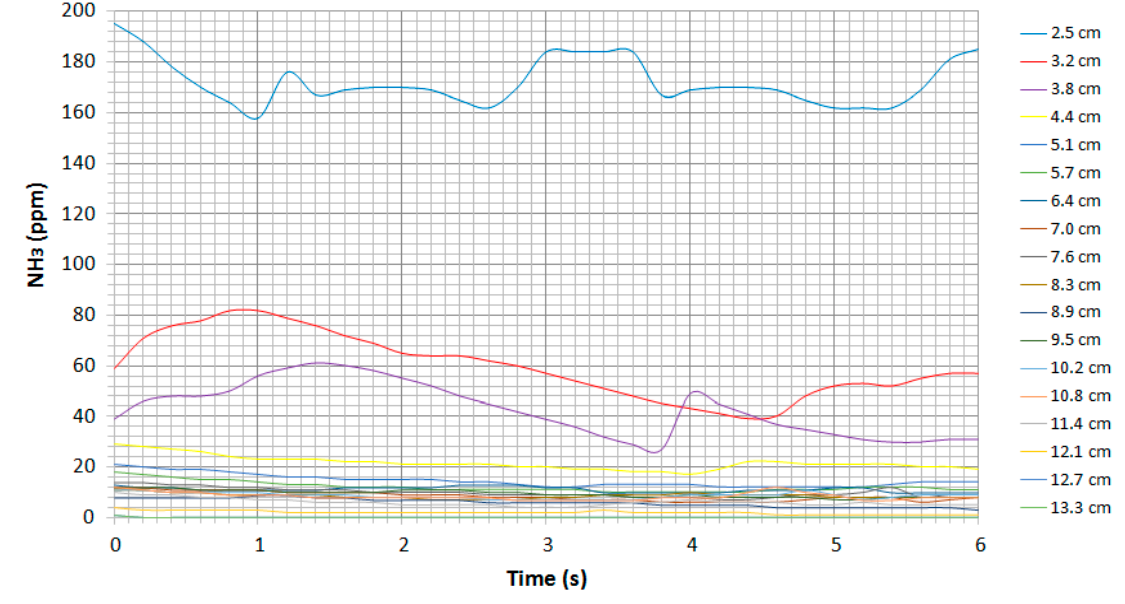
Figure 5. Evolution of ammonia ppm as a function of each distance using the TGS-826 sensor.